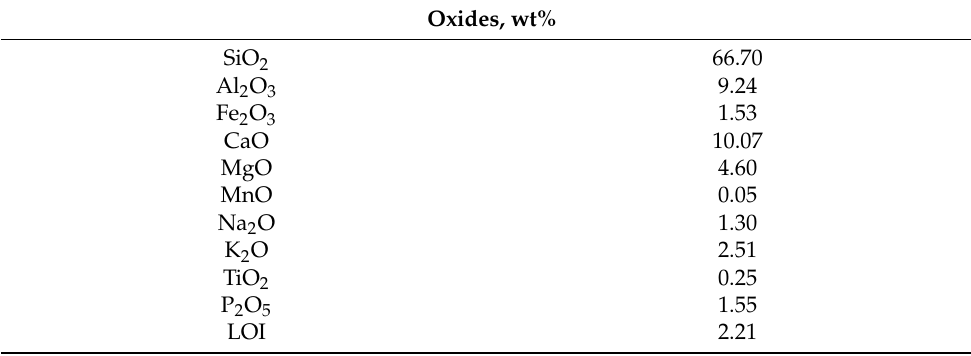
Table 4. Oxides composition of sugarcane bagasse ash (SCBA).